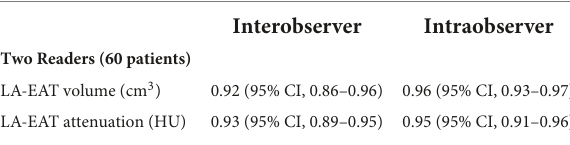
TABLE 3 Interobserver and intraobserver variability